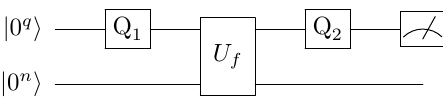
Figure 12: Quantum circuit Q Period